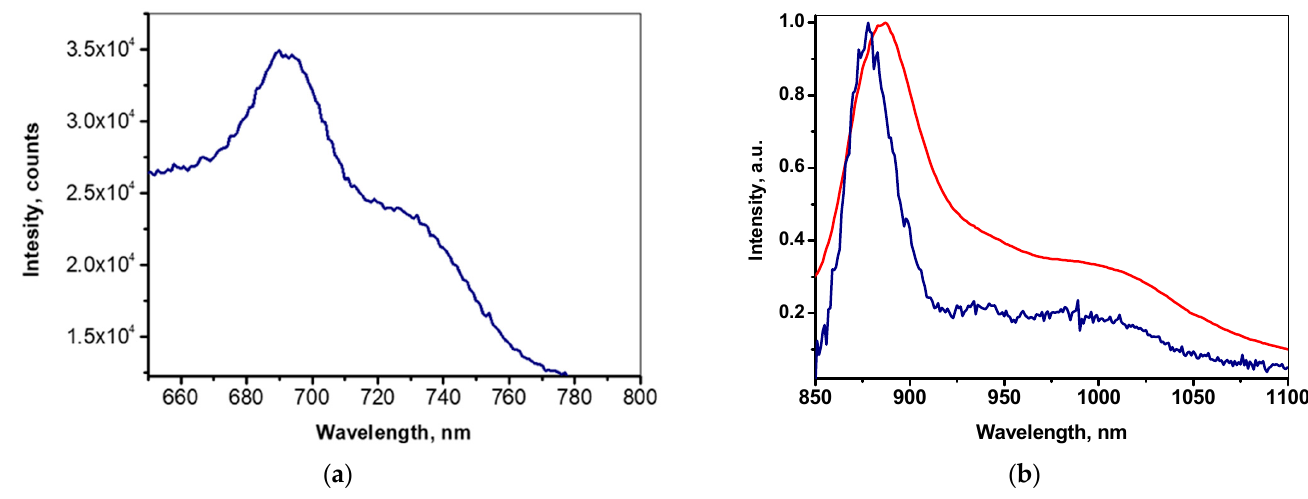
Figure 3. Photoluminescence spectra of the ( a ) Cu ‐ PP ‐ IX RTE film (excitation at 405 nm @ 295 K) and ( b ) Cu ‐ C ‐ e6 dispersed in PS film at 298 K (red line) and at 77 K (blue line), excitation at 400 nm.